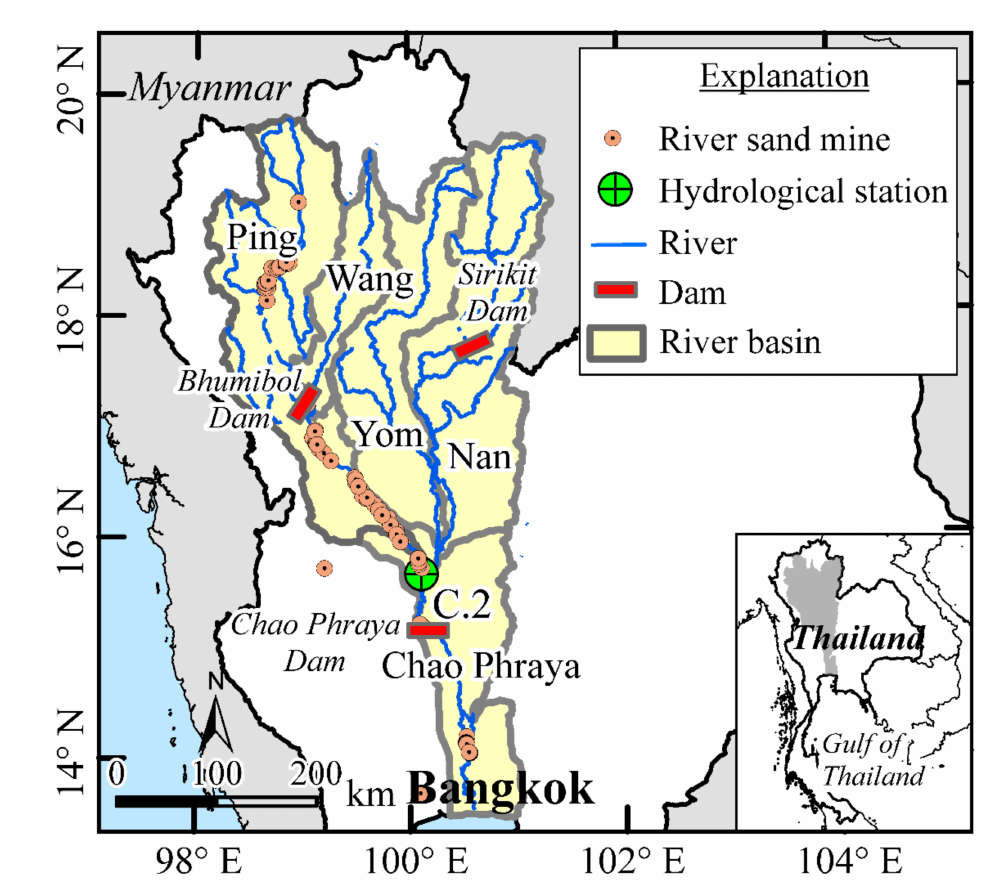
Figure 9. Location of sand mines along the Ping